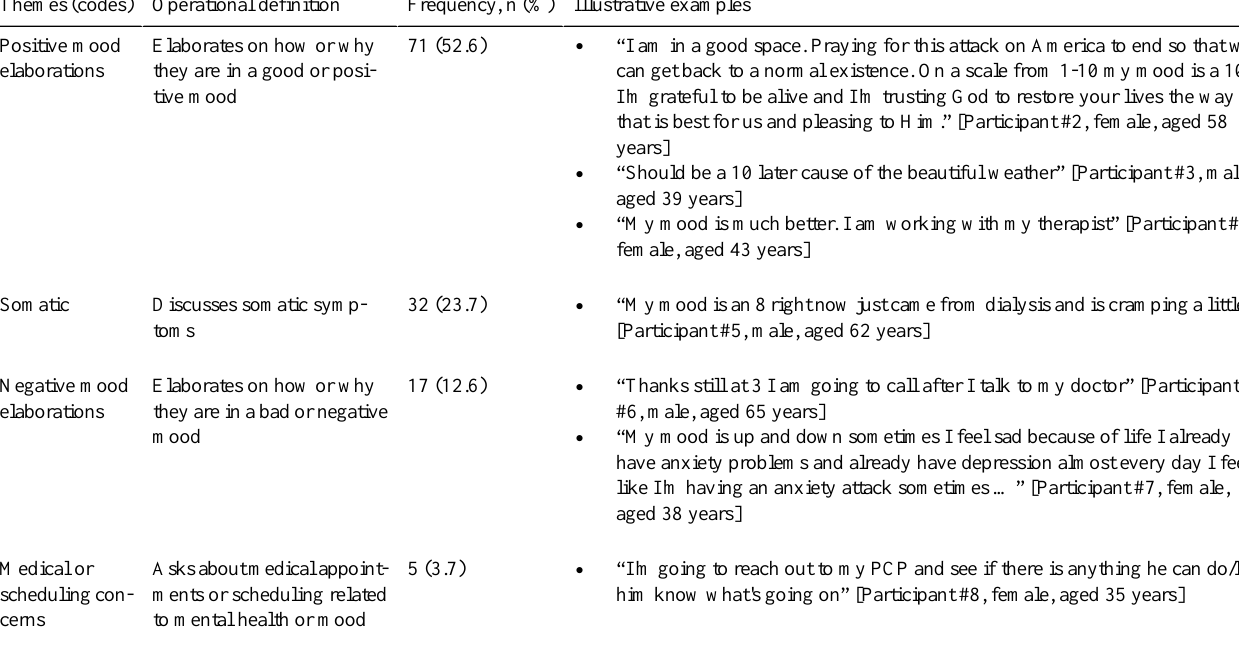
Table 2. Qualitative elaborations on mood (N=135 a